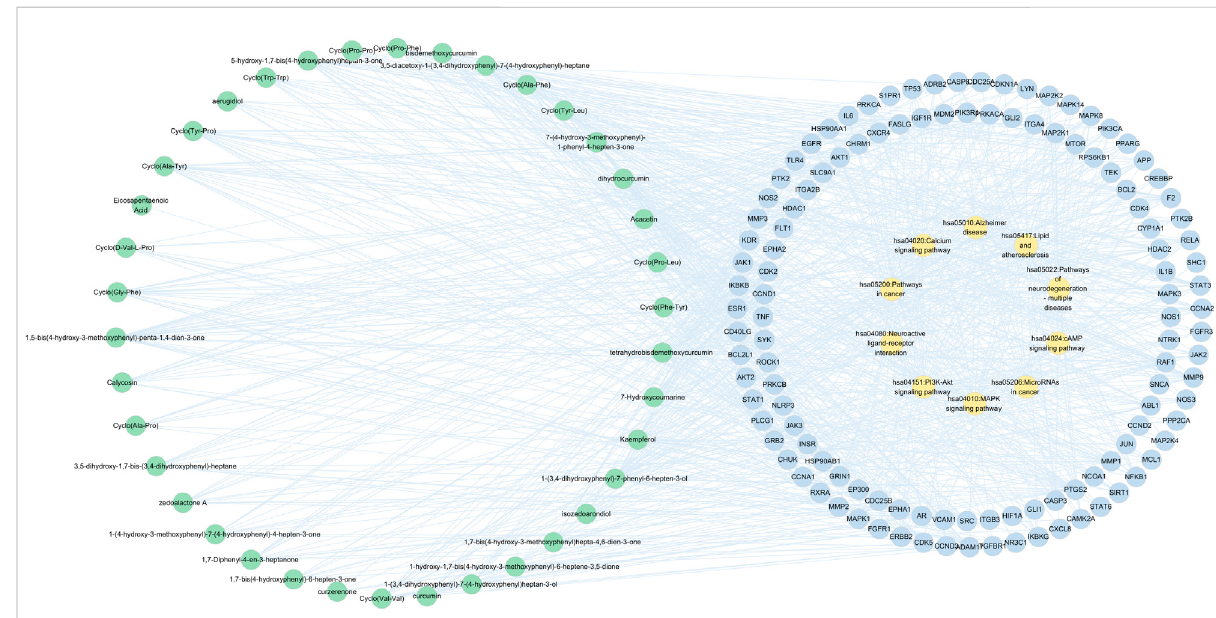
FIGURE 8 Activecompound-keytarget-pathwaynetworkofCR-SRforlivercancer,wheregreennodesresentedactivecompounds,bluenodesdenoted key targets, and orange nodes indicated enriched